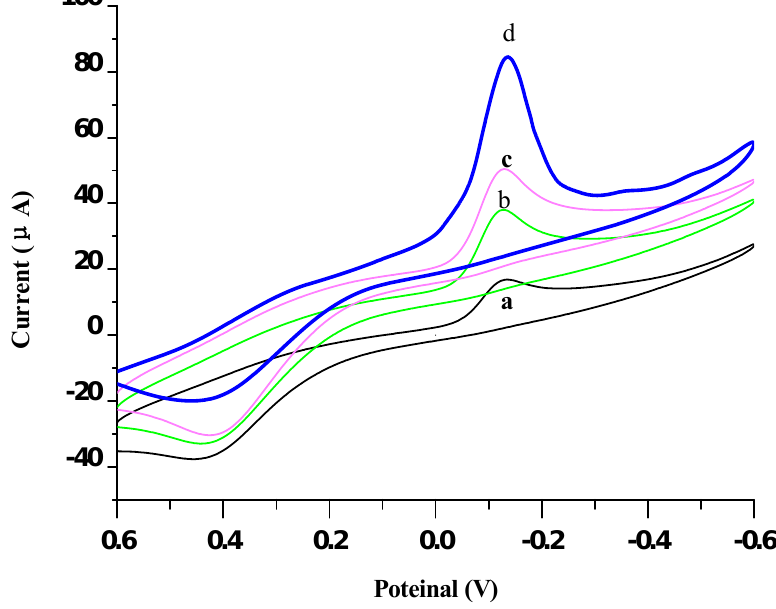
Figure 7. Cyclic voltammograms of the electrochemical sandwich immunosensor toward 5 ng/mL p24 in the absence ( a ) and in the presence of 5 mmol/L H pH 7.0 PBS containing 5 mmol/L HQ by using various signal tags: ( b ) HRP-p24 Ab2; ( c ) EV-p24 Ab2; and ( d ) AuNPs/EV-p24